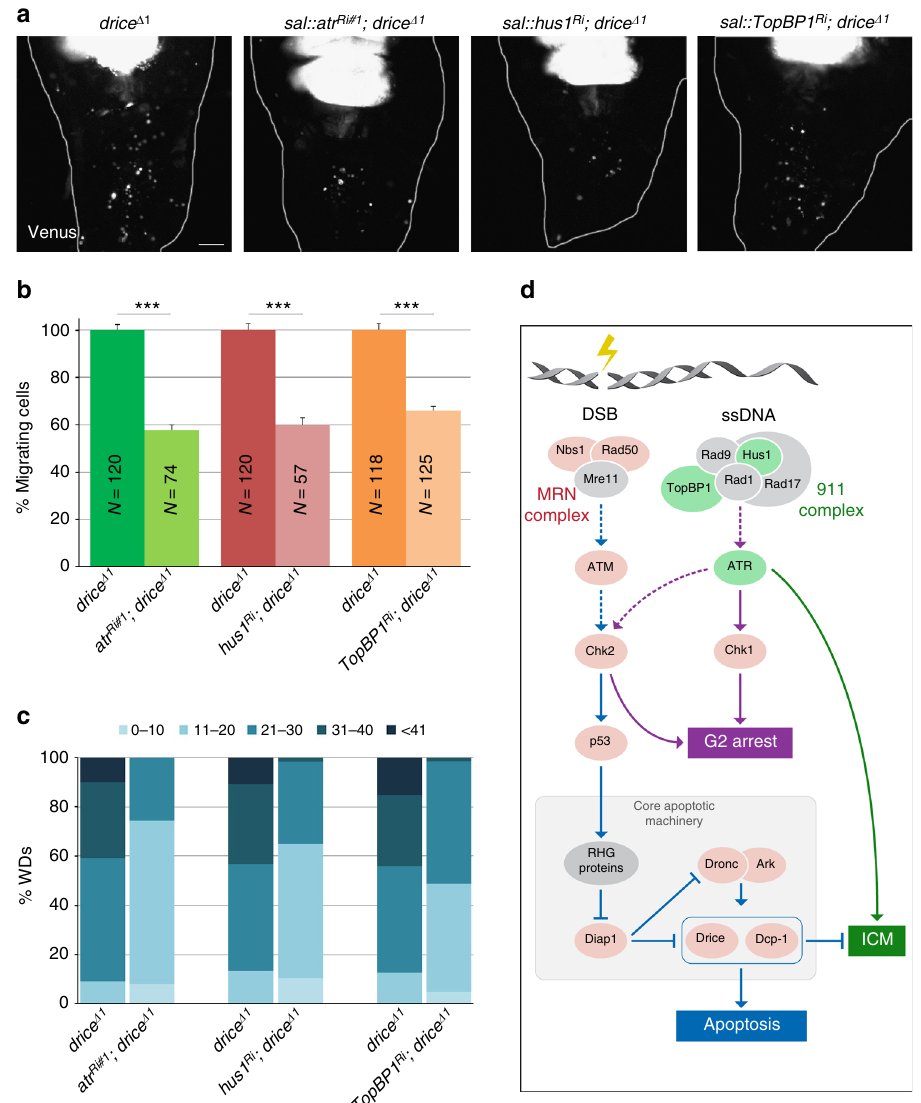
Fig. 6 The 9-1-1/ATR branch of the DNA damage response pathway mediates ICM induction. a – c Pouch area knockdown of components in the 9-1-1/ATR signaling pathway attenuates ICM. Representative images of irradiated WDs (18 Gy, 48 hpi) of the indicated genotypes ( a ), and the corresponding quanti fi cations of ICM levels, presented either as migrating cell number averages relative to control ( b ) or as the percentage of WDs with each of fi ve different migrating cell number categories (color coded by different shades of blue; c ). The examined WD numbers ( N ) are indicated for each graph bar. Error bars indicate s.e.m. ***P < 0.001, two-way ANOVA. Scale bar, 50 µ m. d Illustration of the two branches of the DNA damage response pathway induced by irradiation. Tested components for effects on ICM induction are indicated in red (for no effect) and green (for having an effect). Untested/uncon fi rmed components are in gray. Dashed lines indicate suggested interactions based on data from mammalian systems or when